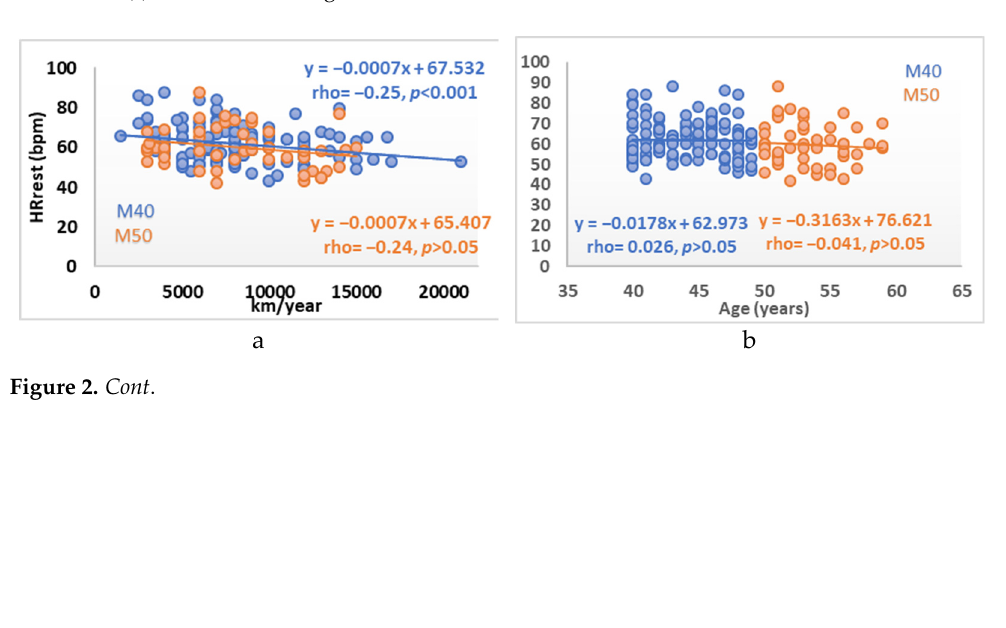
Figure 1. Relationship between body composition (weight, BMI, and fat mass) variables and km/year cycled ( left column) and age ( right column). ( a ) body weight versus cycling kilometers, ( b ) body weight versus age, ( c ) BMI versus cycling kilometers, ( d ) BMI versus age, ( e ) fat mass versus cycling kilometers, ( f ) fat mass versus age.